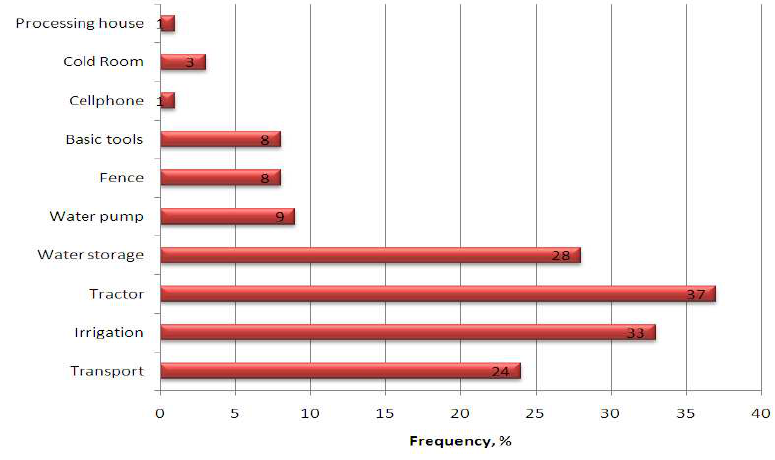
Fig. 16. Technology required to enhance smallholder farmer operations